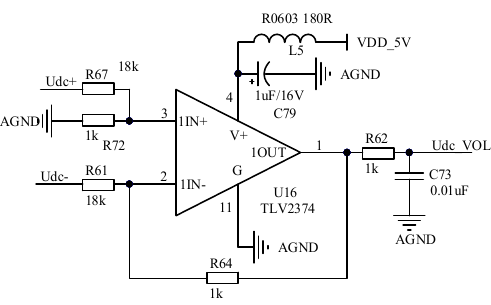
Figure 5. Voltage acquisition and conditioning circuit.